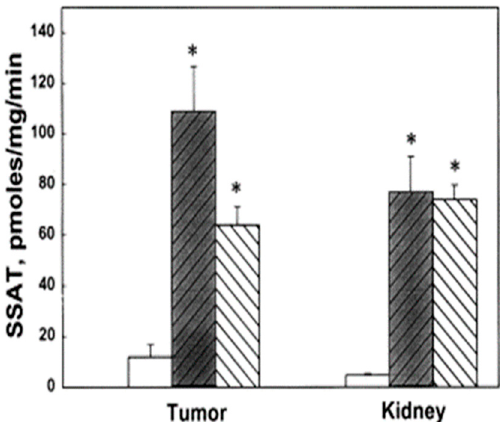
Figure 4. Effect of bis(ethyl)polyamines on SSAT activity in tumors and kidneys of FVB/NTgN (MMTVneu) mice. SSAT levels of control (open bar) and treatment groups, BE-3-3-3 (darkened bar) and BE-3-3-3-3 (striped bar). * Statistically significant ( p < 0.01) compared with controls by ANOVA followed by Dunnett’s test. Reproduced with permission from [66].